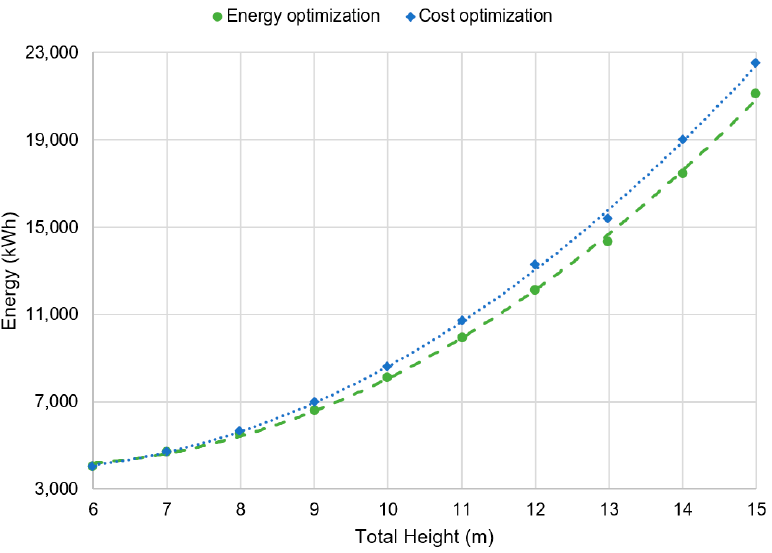
Figure 6. Relation between embodied energy and wall height.